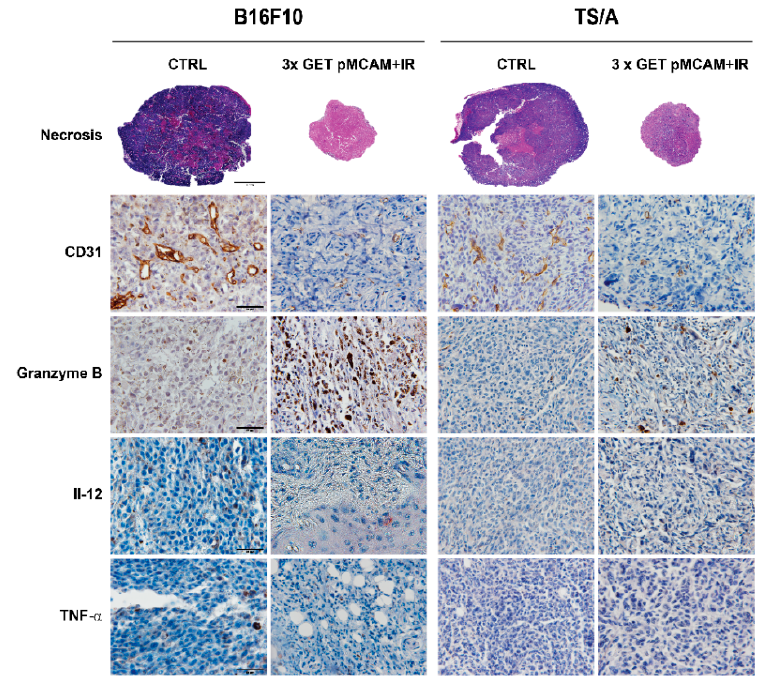
Figure 6. Histological sections of BF1610 melanoma nad TS/A carcinoma after gene electrotransfer (GET) with plasmid-encoding shRNA against MCAM (pMCAM) and single-dose irradiation (15 Gy) on day 6 after the beginning of the therapy. Brown staining represents CD31-positive tumor vessels or granzyme B-positive cells. Red staining represents IL-12 positive cells or TNF- α positive cells.